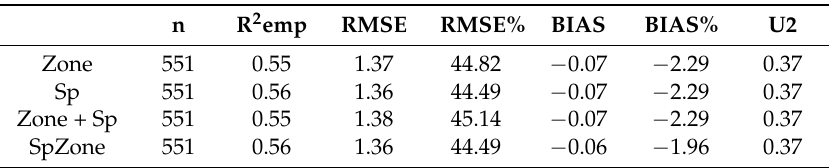
Table 3. Goodness-of-fit statistics for the natural logarithm of annual increment in diameter breast height (AIDBH, mm year − 1 ) for the CV regression model using test